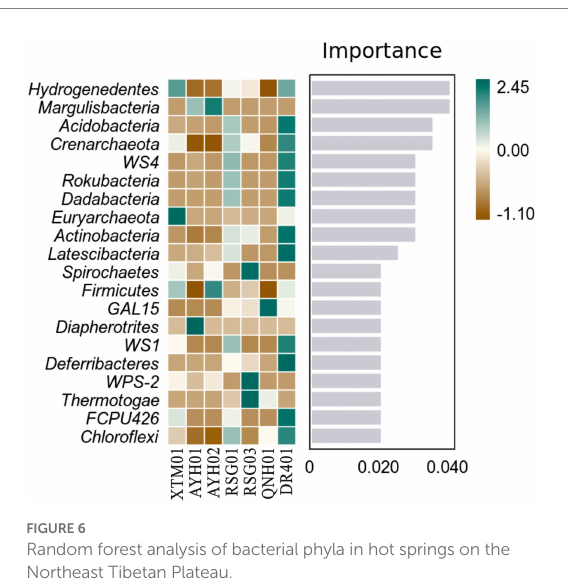
FIGURE 6 Random forest analysis of bacterial phyla in hot springs on the Northeast Tibetan Plateau.